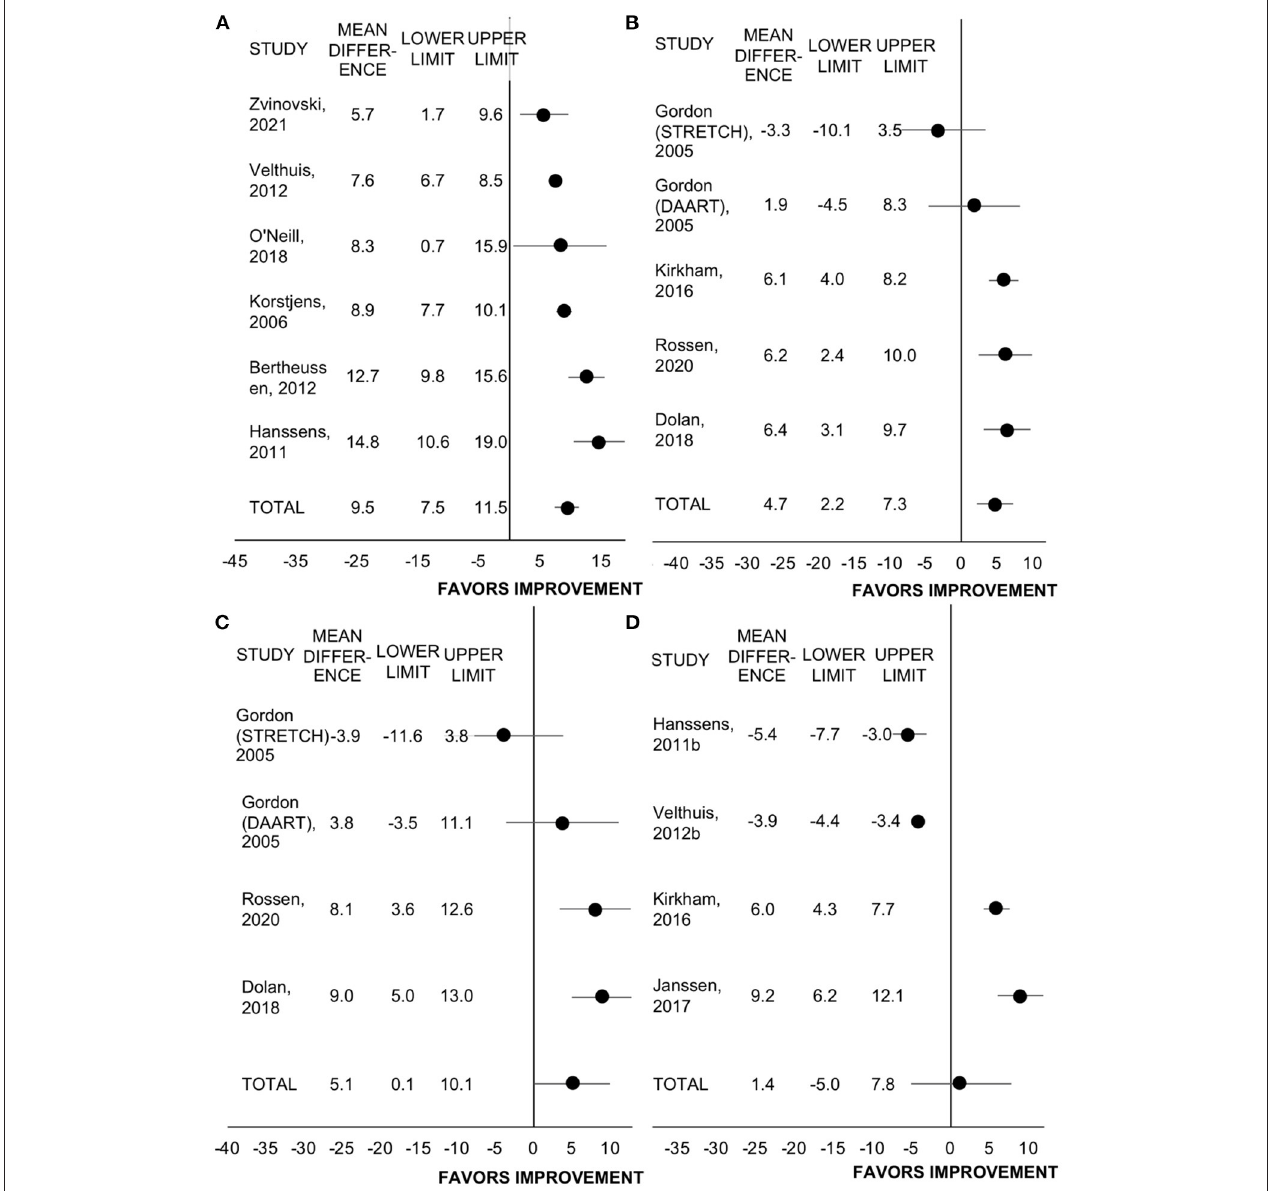
FIGURE 4 | Forest plot displaying mean difference and 95% CIs for the impact of rehabilitation on measures of health-related quality of life: (A) EORTC-QLQ-C30; (B) FACT-General; (C) FACT-Breast; (D)